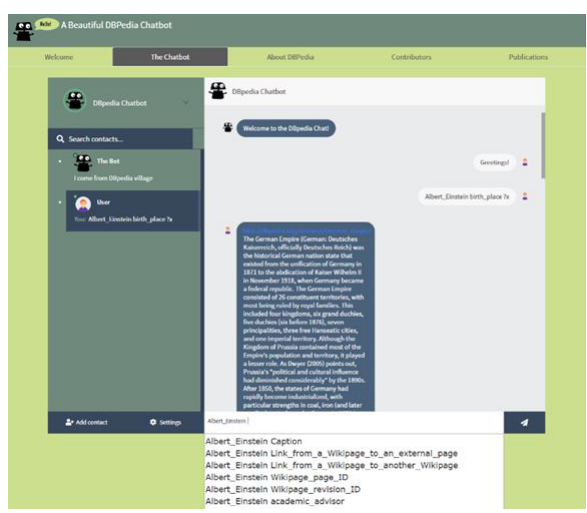
Figure 2. A screenshot of the graphical user interface (GUI).